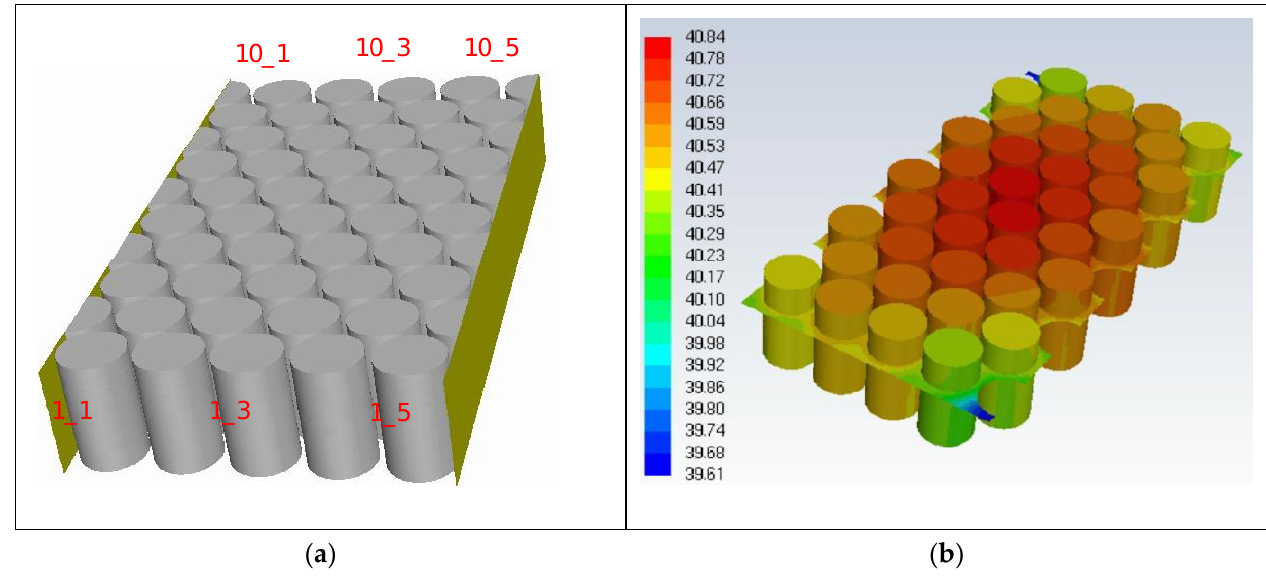
Figure 8. ( a ) Simulation domain of the CFD model implemented in ANSYS fluent and ( b ) battery cells temperature (in ℃ ) at the end of a charged/discharge cycle, without active cooling.